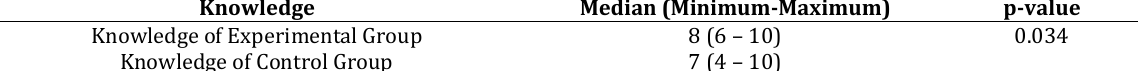
Table 3. Behaviour of the modification of the experimental-group’s lifestyle No The behaviour of lifestyle